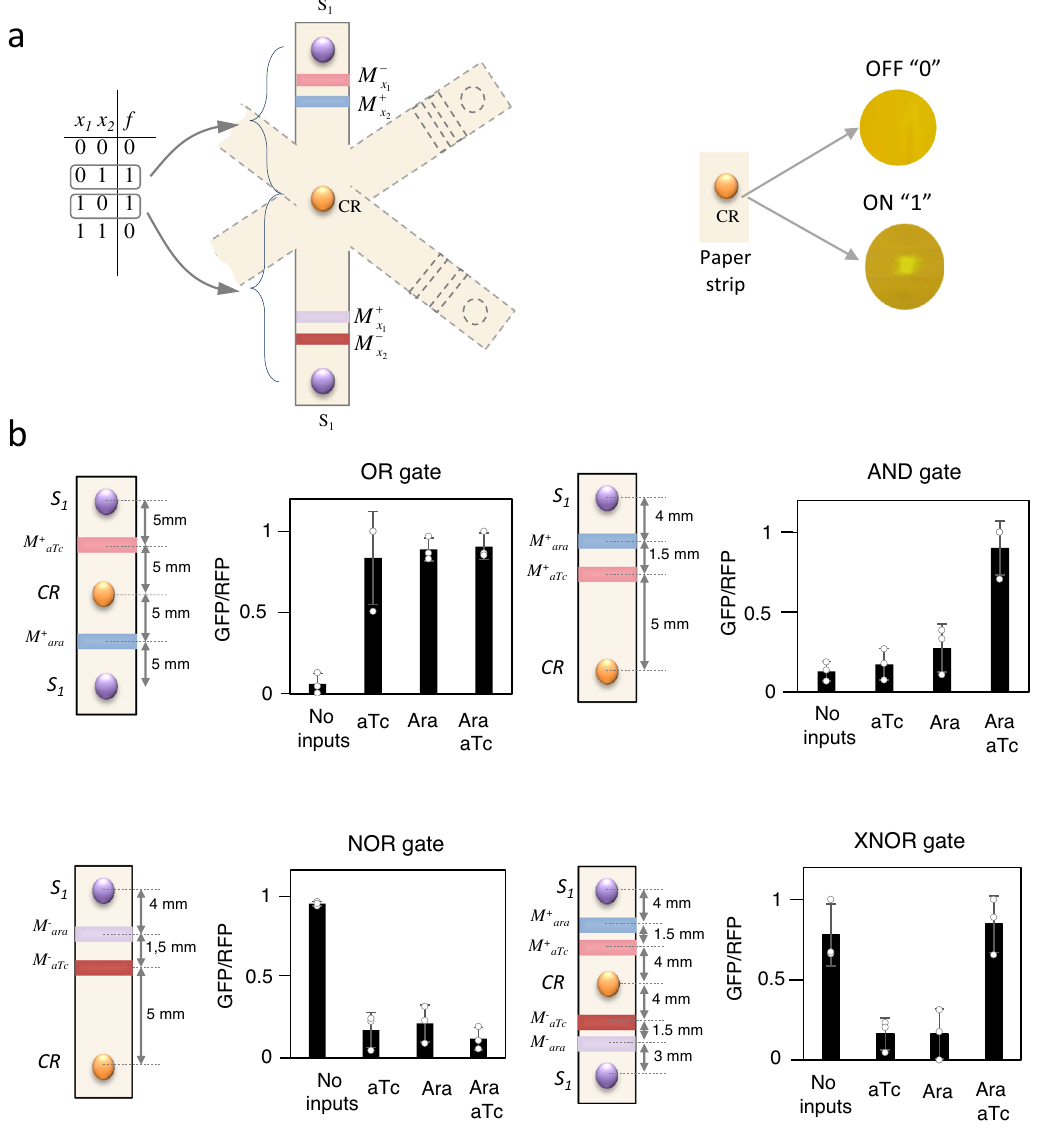
Fig. 3 General multi-branch architecture for implementation of digital circuits. a Schematic representation of the multi-branch implementation of a truth table. b Implementation of different logic gates. A schematic representation of the cells used in each paper strip and their corresponding distance points is given (Left). Gates with two sources of S 1 (OR and XNOR gates) are circuits carrying two branches, while the other gates (NOR and AND gates) can be implemented with just one branch. Input concentrations are Ara = 10 − 3 M and aTc = 10 − 6 M. M + aTc and M − aTc are, respectively, positive and negative modulatory cells responding to aTc. M + ara and M − ara are, respectively, positive and negative modulatory cells responding to arabinose. S 1 cells produce AHL constitutively and CR are the reporter cells. Error bars are the standard deviation (SD) of three independent experiments. The average fold change has been obtained from the mean of ON and OFF states from each circuit. OR gate 14.31x, AND gate 6.21x, NOR gate 6.58x, XNOR gate 5.6x. Source data are provided as a Source Data fi